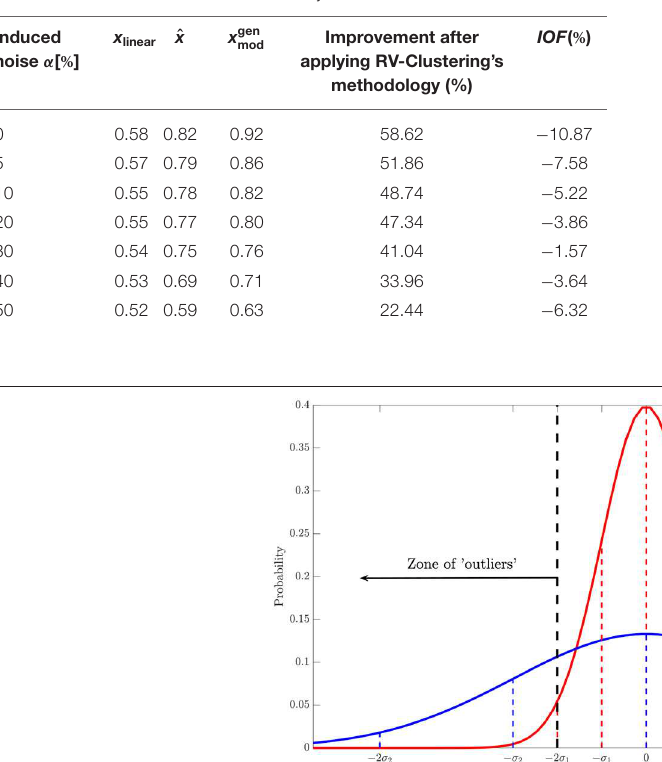
TABLE 3 | Evolution of performance (accuracy) of the models generated in different progressive steps of the proposed methodology, applied to noisy variations of the dataset used in Case Study 3.